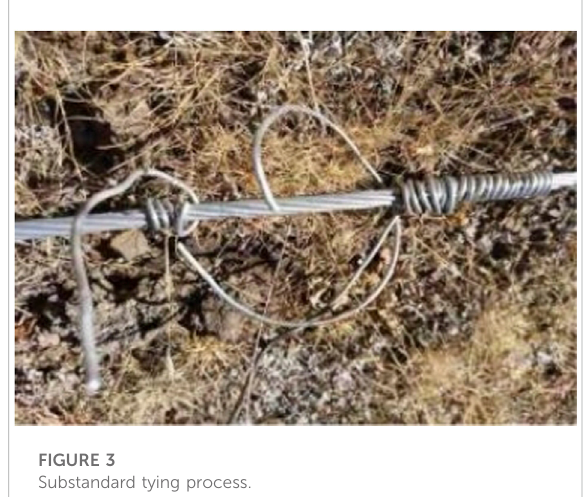
Substandard tying